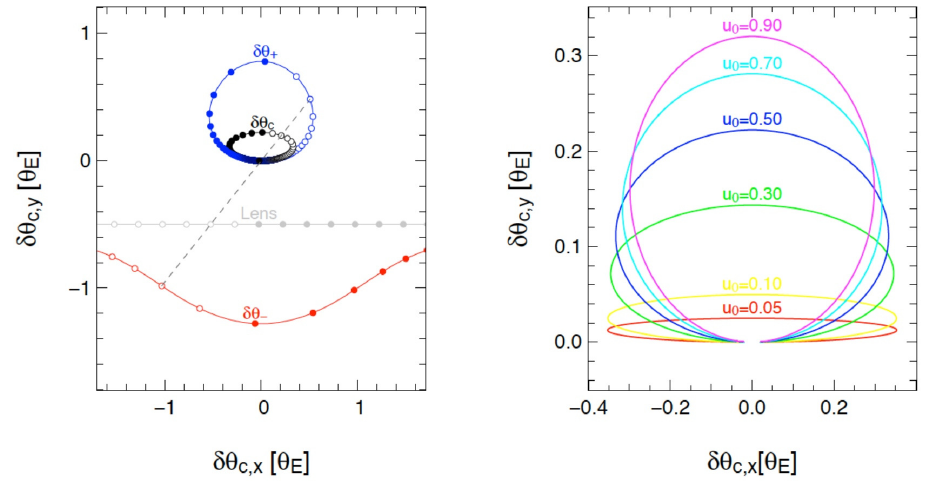
Figure 2. Centroid shifts of a single lens microlensing event. ( left ) trajectories of the plus-image (blue), minus-image (red), and the centroid (black). The lens trajectory is shown in grey. We assume t 0 = 0, t E = 10 days and u 0 = 0.5 θ E ; ( right ) centroid shifts for different values of u 0 . This figure is adopted from “Lee et al., Mon. Not. R. Astron. Soc. 2010 , 407 , 1597–1608”